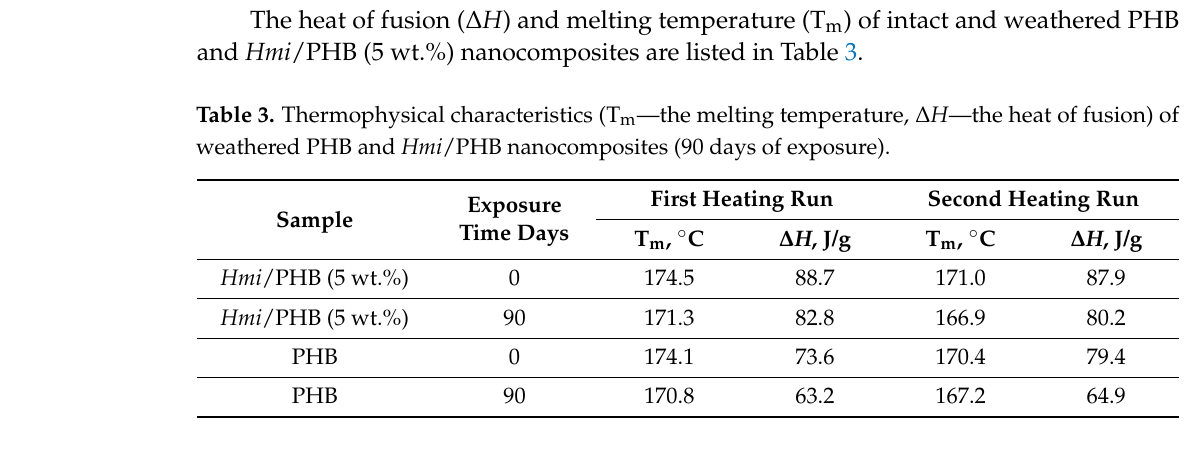
Figure 10. DSC scans of hemin/PHB (5 wt.%) nanocomposites before (yellow line) and after weathering (blue line): ( A ) first heating run and ( B ) second heating run.